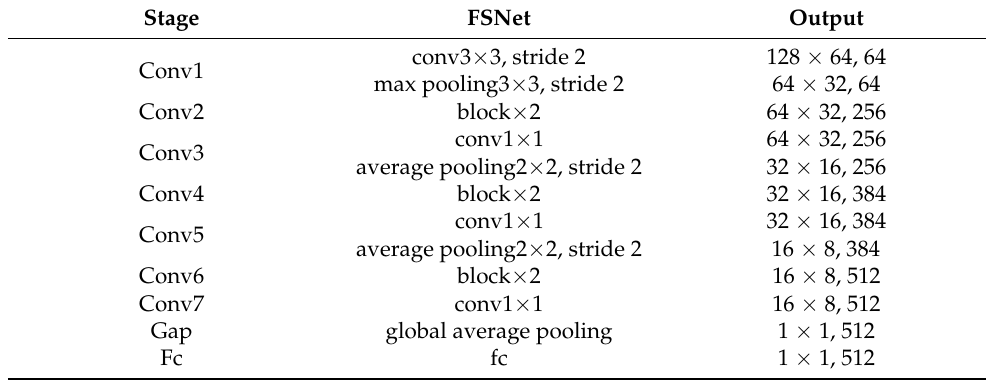
Figure 8. The structure of the full-scale feature extraction block. FSNet is built by a simple stacked full-scale feature extraction block. The details of the network architecture are shown in Table 1. Table 1. The architecture of FSNet with input image size 256 × 128.